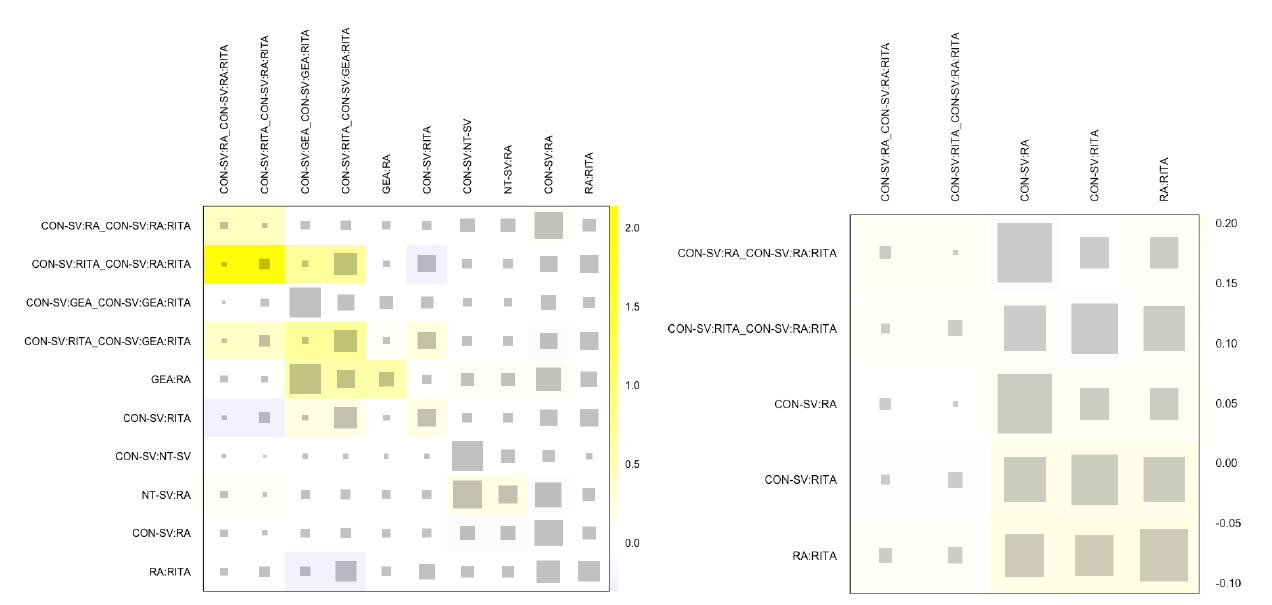
Fig. S5 - Net heat plot evaluating for inconsistency (i.e., disagreement between direct and indirect evidence) in the network model for A) graft patency and B) late mortality. The areas of gray squares represent the relative contributions of designs listed in the columns to the network estimate of designs listed in the rows. The colors are associated with changes in inconsistency between direct and indirect evidence in designs listed in the rows after detaching the effect of designs listed in the columns. Yellow colors indicate a decrease (the stronger the intensity of the color, the stronger the change). CON-SV=conventionally harvested saphenous vein; GEA=gastroepiploic artery; NT-SV=no-touch saphenous vein; RA=radial artery; RITA=right internal thoracic